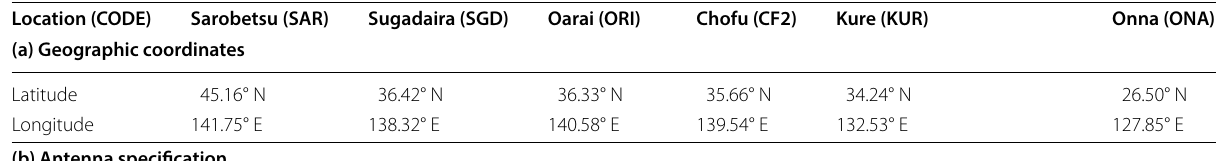
Table 1 Specifications of receiver components